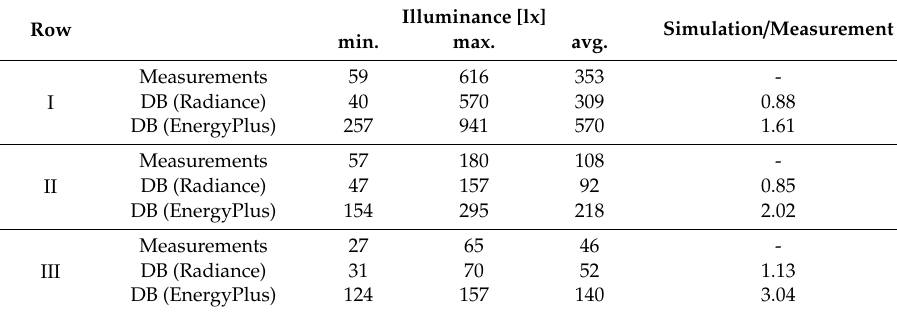
Table 2. Illuminance values summary for cloudy conditions (11 January 2019).